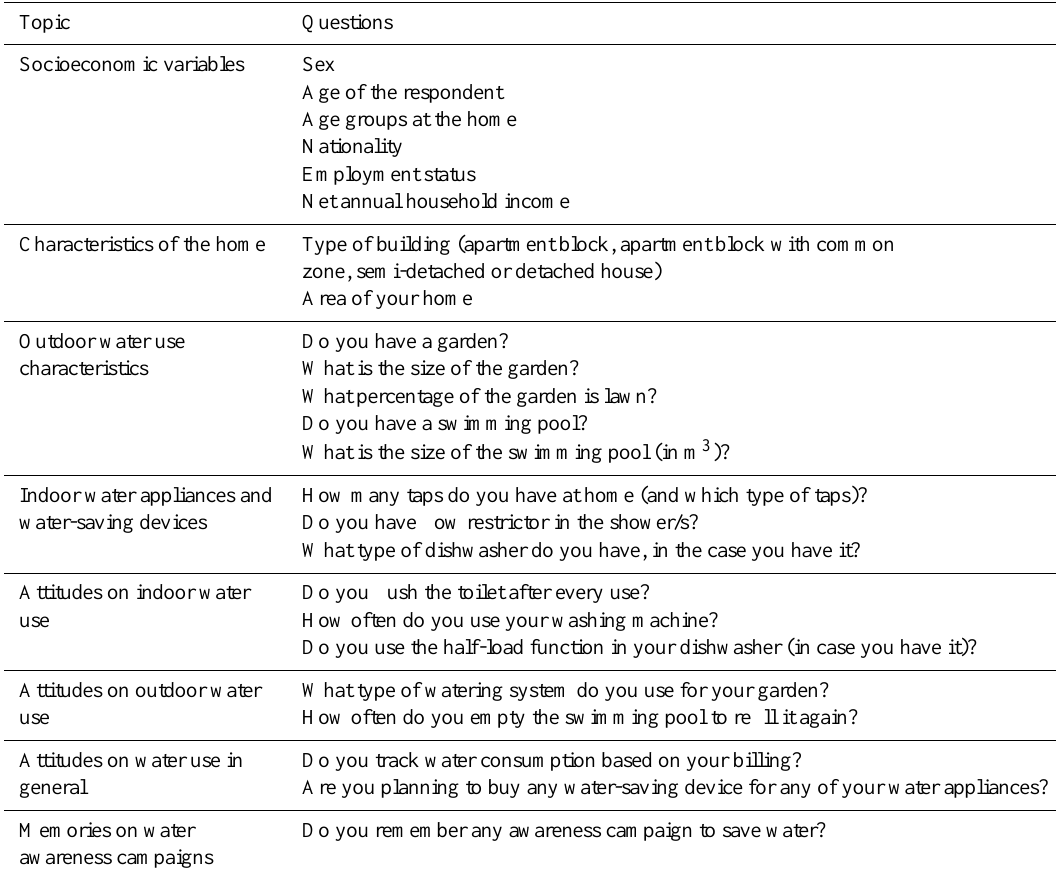
Table 2. Examples of questions of the survey.